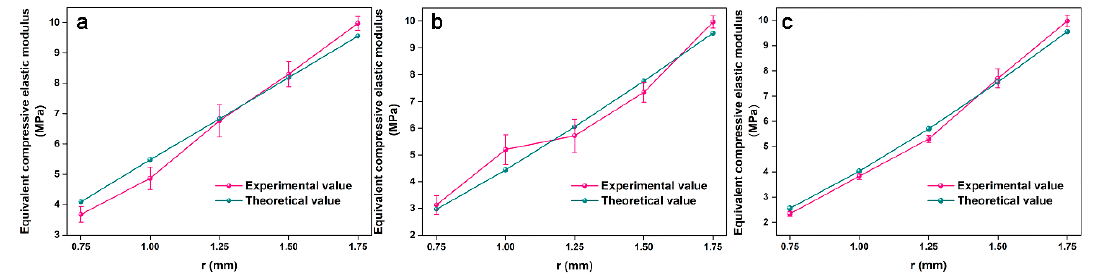
Figure 9. Equivalent compressive elastic modulus of ( a ) n = 1, ( b ) n = 2, and ( c ) n = 3.